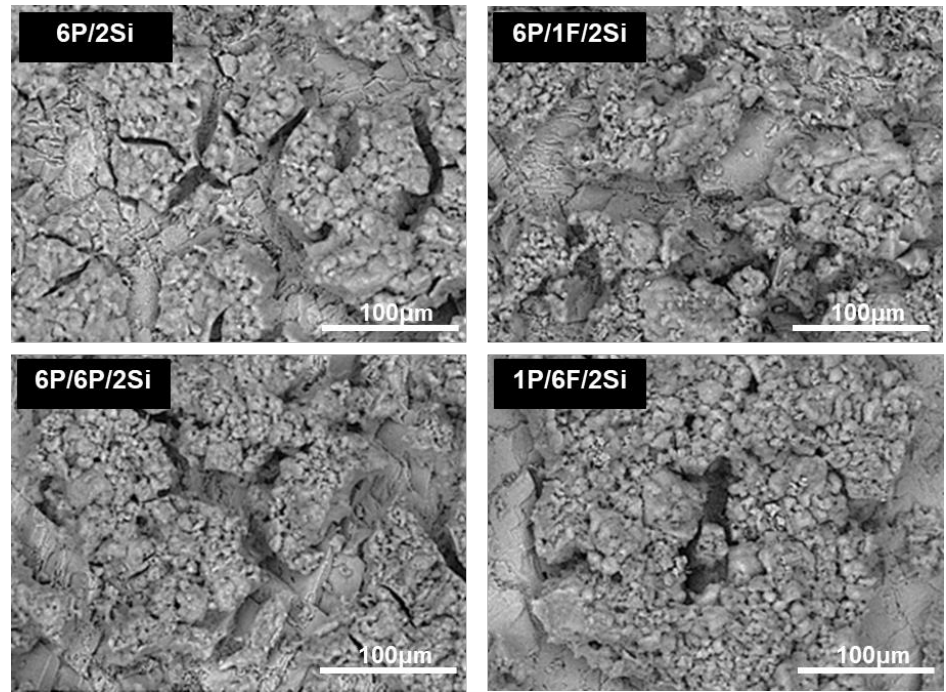
Figure 5. Surface structures of the 2Si-based coatings, which were prepared using 2% w / w NP concentration and different P and F ratios.